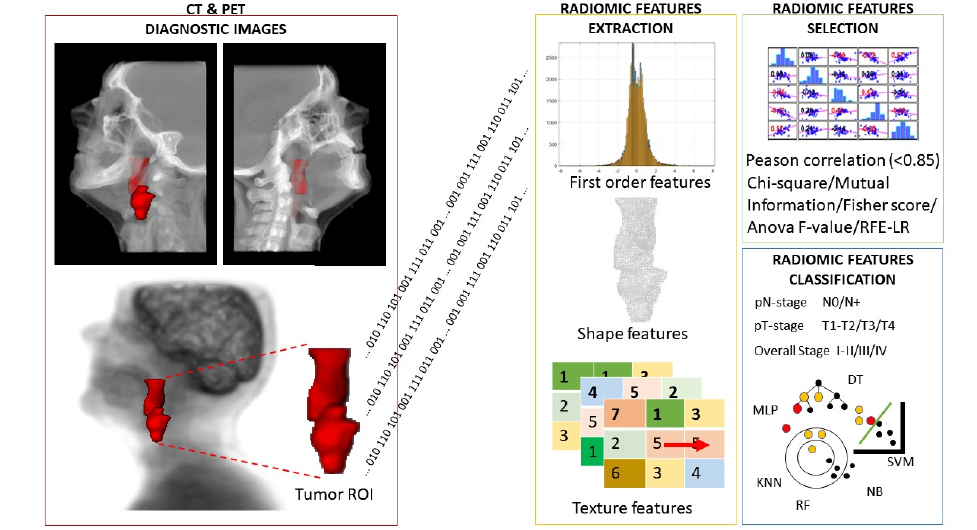
Figure 1. Radiomics Head and Neck pipeline. Left part: CT and PET images have been collected and selected for the feature extraction. The red portion is the tumor ROI of the patient, from which the radiomics features have been calculated. Both CT and PET tumor ROI have been included. Middle part: the process of radiomics extraction schematizes our workflow in terms of feature extraction (first-order, shape and texture features, well described in Section 2.3), both from the original and the filtered (LoG and wavelet) images, except the shape 3D for the filtered image. Right part: the upper side synthesizes the feature selection process, while the bottom side resumes the classification task and the applied models; see Section